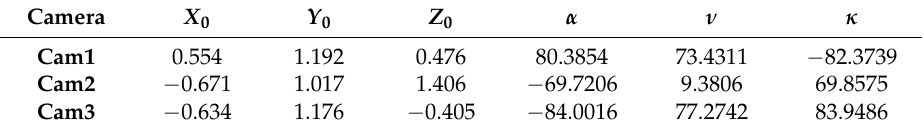
Table 5. Camera exterior orientation at the three locations (units of translations in (m), angles in (deg)).